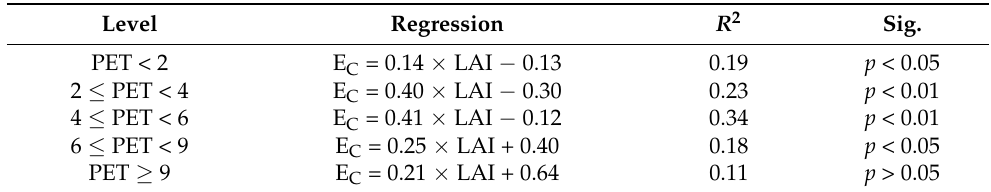
Figure 10. Plot showing the role of PET in response of canopy transpiration to LAI in study period. ( a ) LAI; ( b ) PET. Table 6. The response of Ec to LAI at varied PET levels.